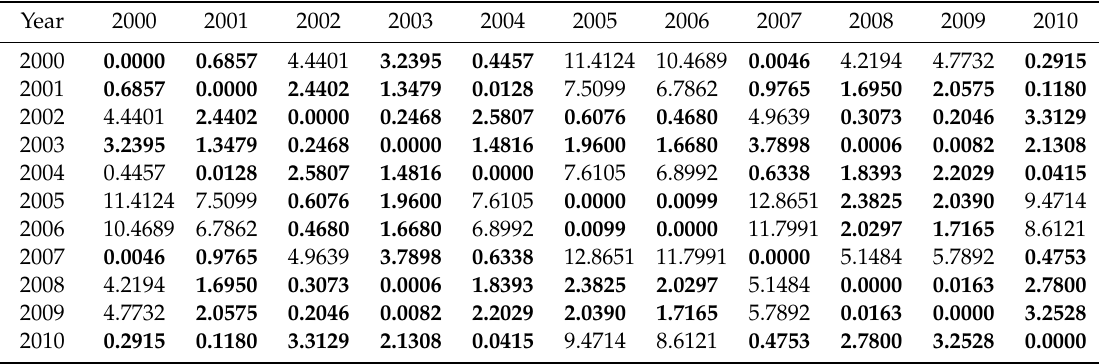
Table A2. Levene’s test for equality of variances, bold print if H 0 was accepted at α = 0.05.